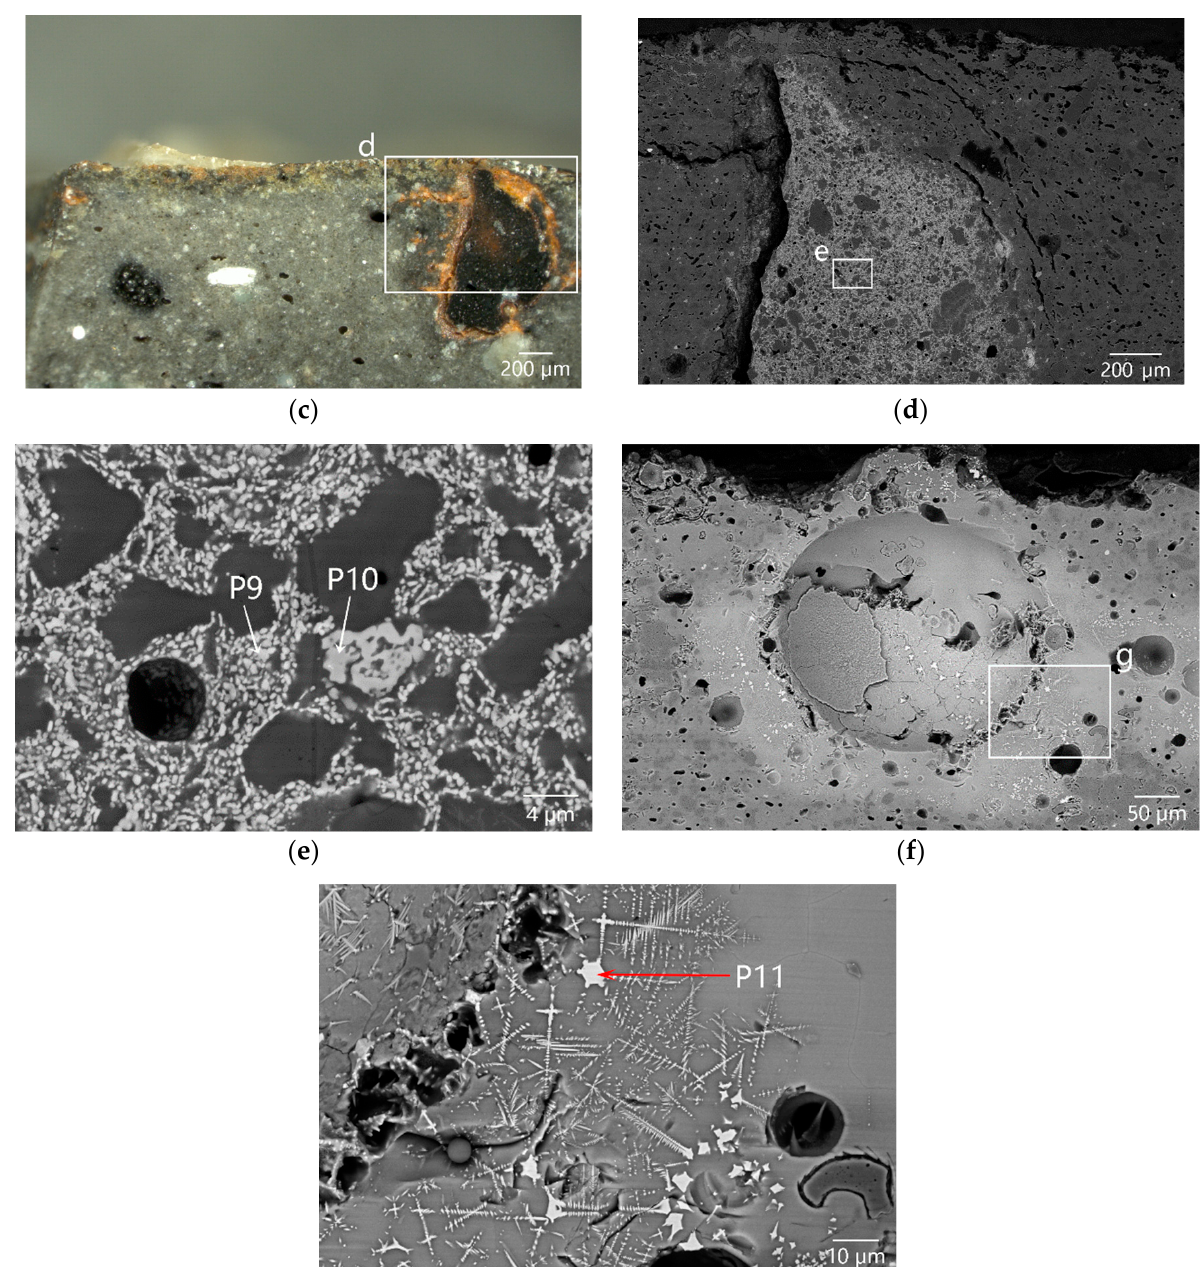
Figure 6. Cross-sectional morphology of sample DL-3: ( a ) OM image showing that an open pore on the surface of the inner surface was polluted by iron rusts, then filled with fine sea sands, and finally covered by red coral skeletons; ( b ) SEM image of the enlarged image of the box in ( a ); ( c ) OM image of the black blocks around the inner surface of the body; ( d ) SEM images of the enlarged image of the box in ( c ); ( e ) SEM image of the enlarged image of the box in ( d ) showing a large number of quartz particles in the black blocks wrapped with iron oxides and rutile microcrystals; ( f ) SEM image of the large bubble near the body/glaze interface; and ( g ) SEM image of the enlarged image of the box in ( f ), showing that a lot of iron oxide dendrites were precipitated from the iron-rich glass phase around the large bubble.